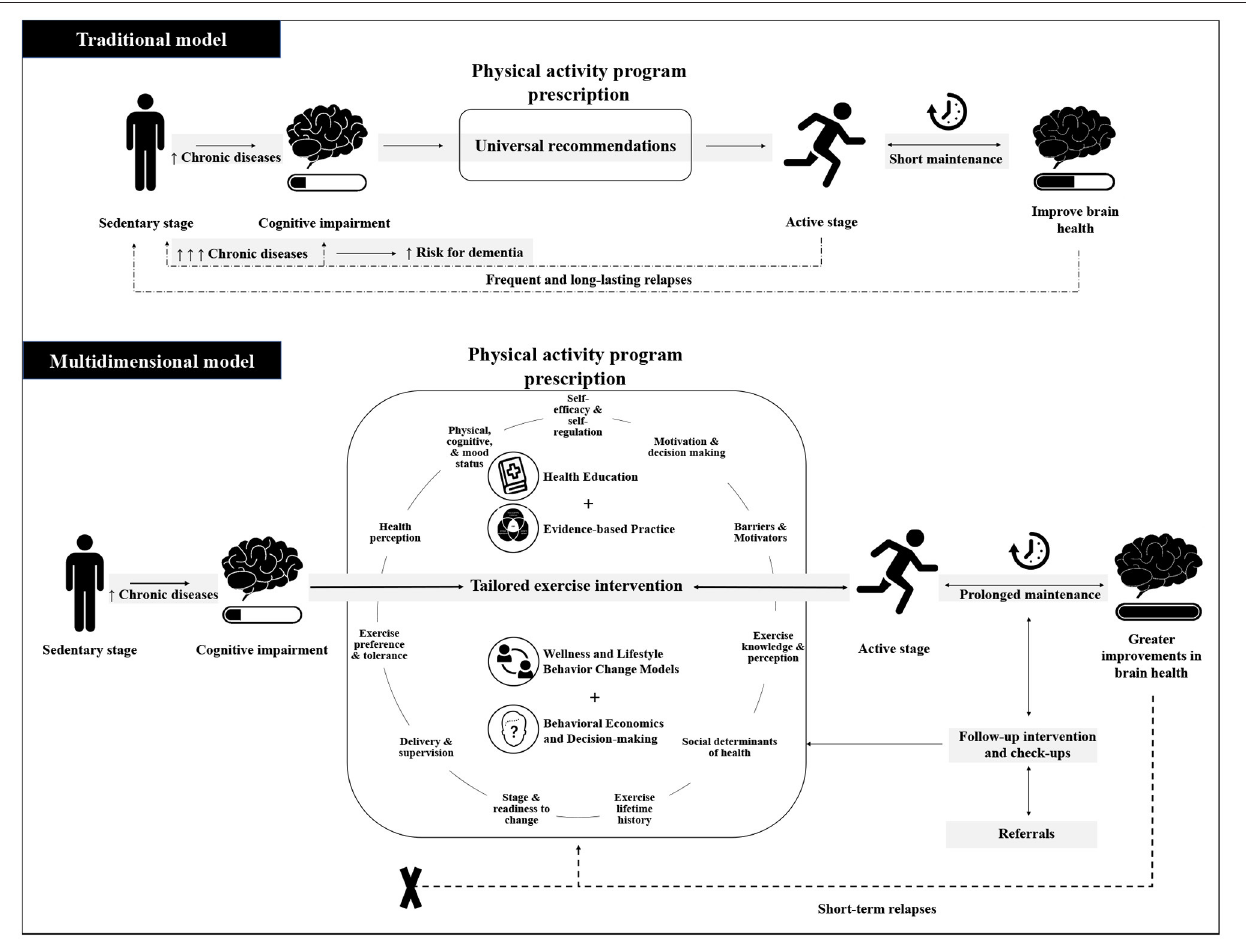
FIGURE 1 | Schematic illustration of traditional model vs. multidimensional model. The traditional model emphasizes universal physical activity recommendations as the main component of an exercise program. The multidimensional model focus on implementing simple ways to effectively translate current guidelines tailored to the needs of the aging individual by screening all listed factors believed to influence adherence and combining all available strategies including health education, evidence-based practice, wellness and lifestyle behavior change models, and behavioral economics and decision-making strategies. The successful assessment and intervention prescription will affect expected prolonged maintenance in a physically active stage and greater improvements in brain